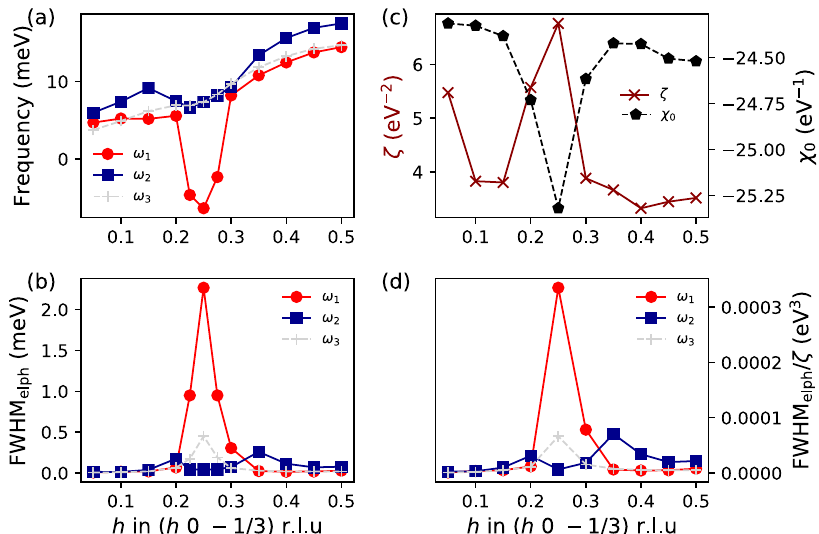
Fig. 4 Electron – phonon interaction vs Fermi surface nesting. a Calculated harmonic phonon spectra of 1 T -VSe 2 along ( h 0 -1/3) r.l.u. Only acoustic modes are shown. The gray line denotes the mode silent in IXS, which is labeled as ω 3 here. b Phonon linewidth (full width at half maximum) given by the electron – phonon interaction for the same modes. c Real part of the non-interacting susceptibility, χ 0 , as well as the nesting function, ζ , at the same wave vectors. d Ratio between the full width at half maximum given by the electron – phonon interaction and the nesting function.